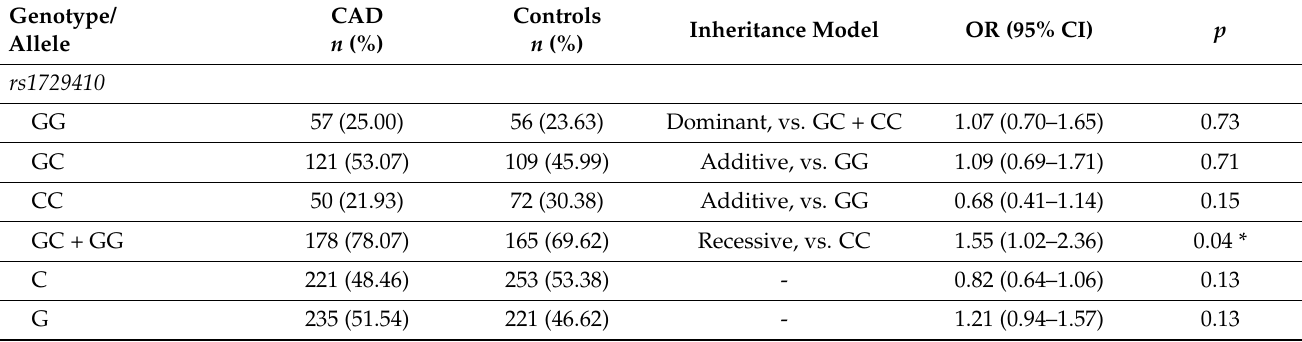
Table 3. Genotype and allele frequencies of analyzed polymorphisms in patients (CAD) and